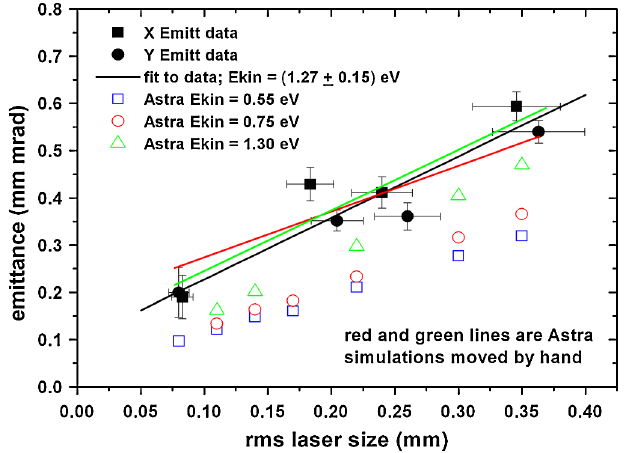
Fig. 15(a) for a beam with initial beam rms size of 0.3 mm in both planes and an initial bunch length of 3.4 ps. Based